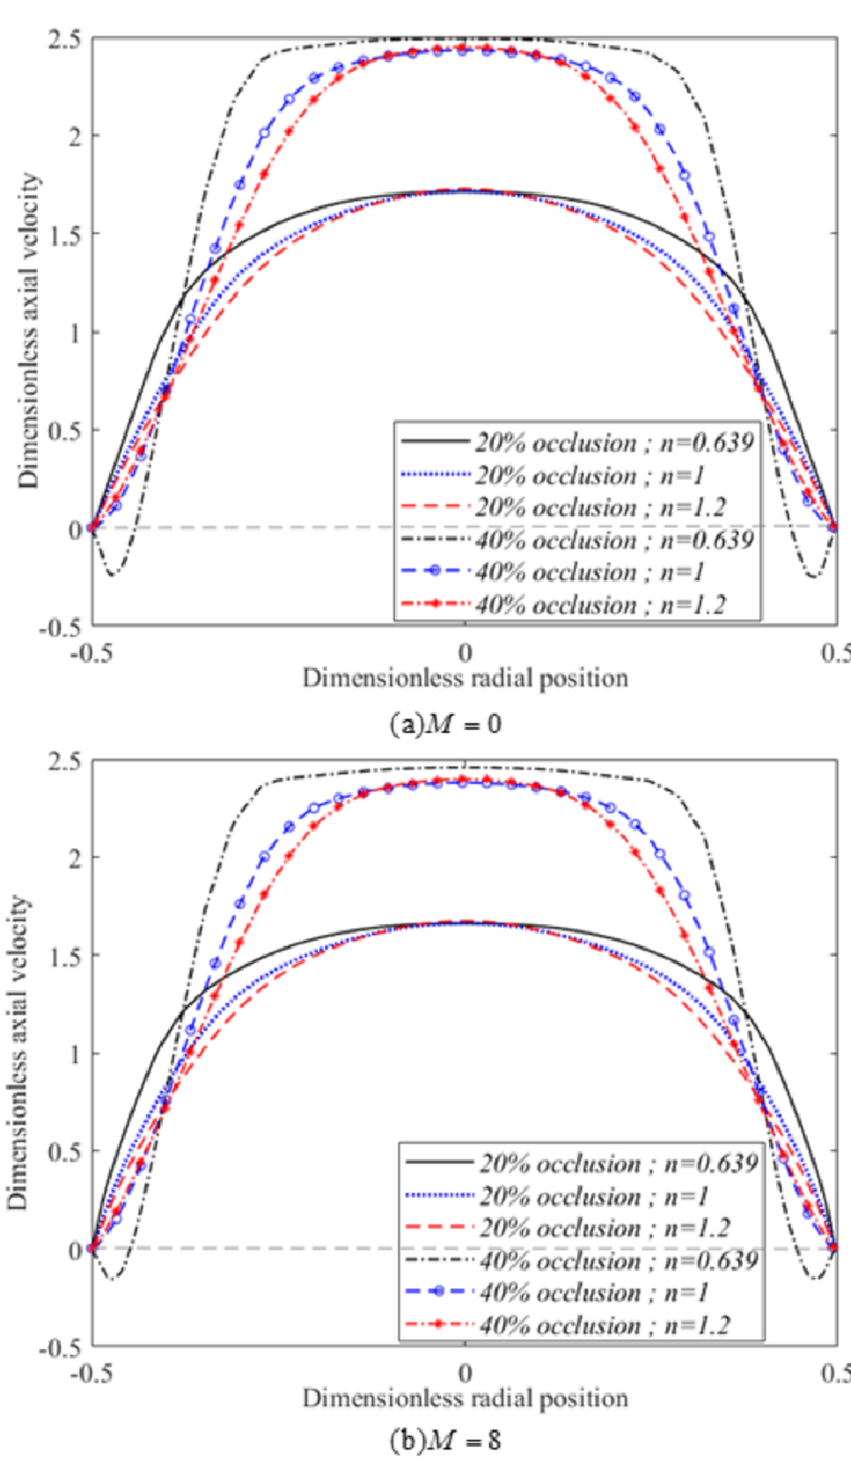
Fig 8. Variation of axial velocity with different stage of stenosis severity and Hartmann number at x = 1 (Re = 300) for: (a) M = 0 and (b) M = 8.